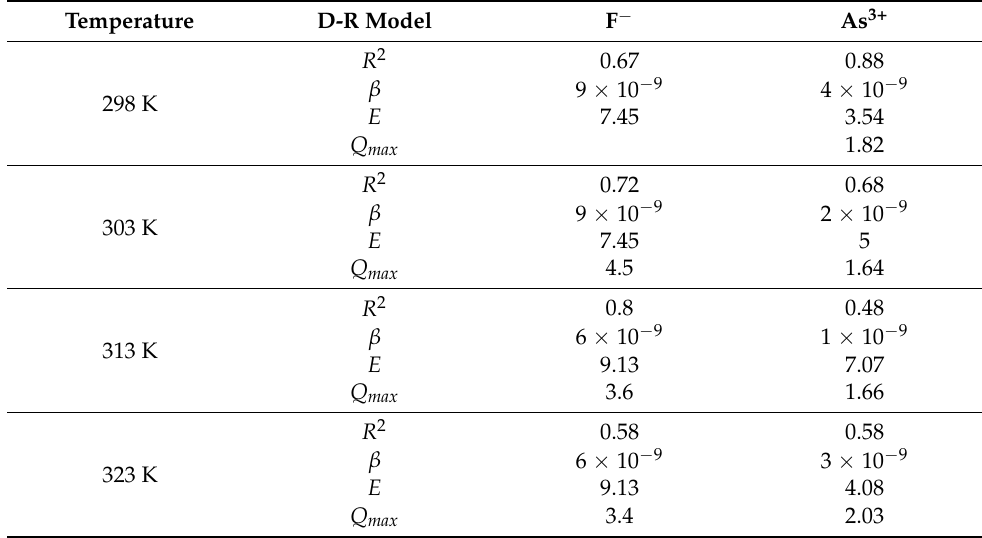
Table 6. D-R isotherm model parameters of F − and As 3+ onto the Fe-pPD composite.